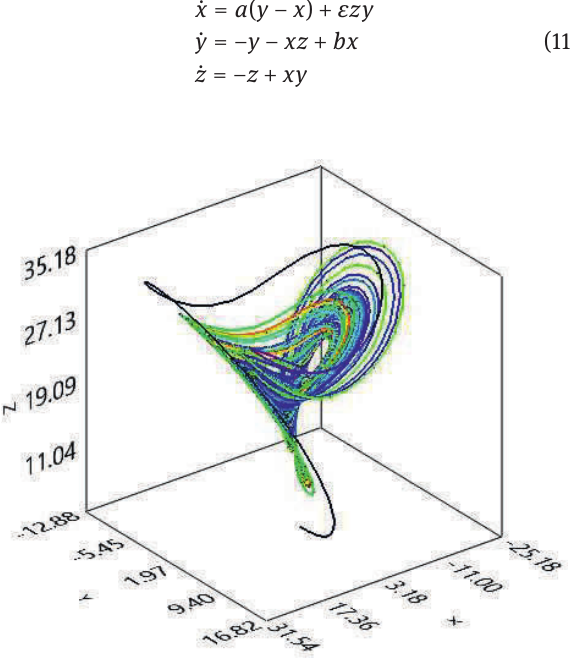
Fig. 1: 3D attractor of the PMSG model.